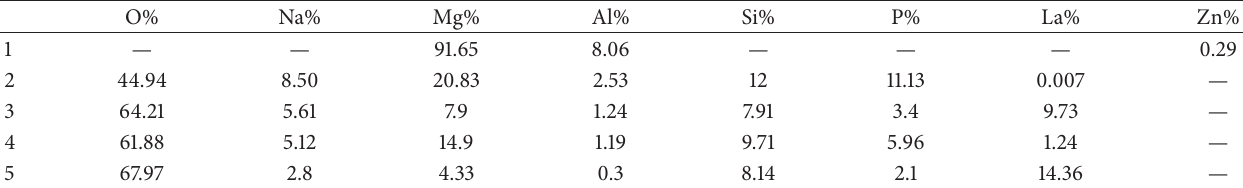
Table 4: Quantitative results (at %) of EDS analysis of the cross-sectioned and surface